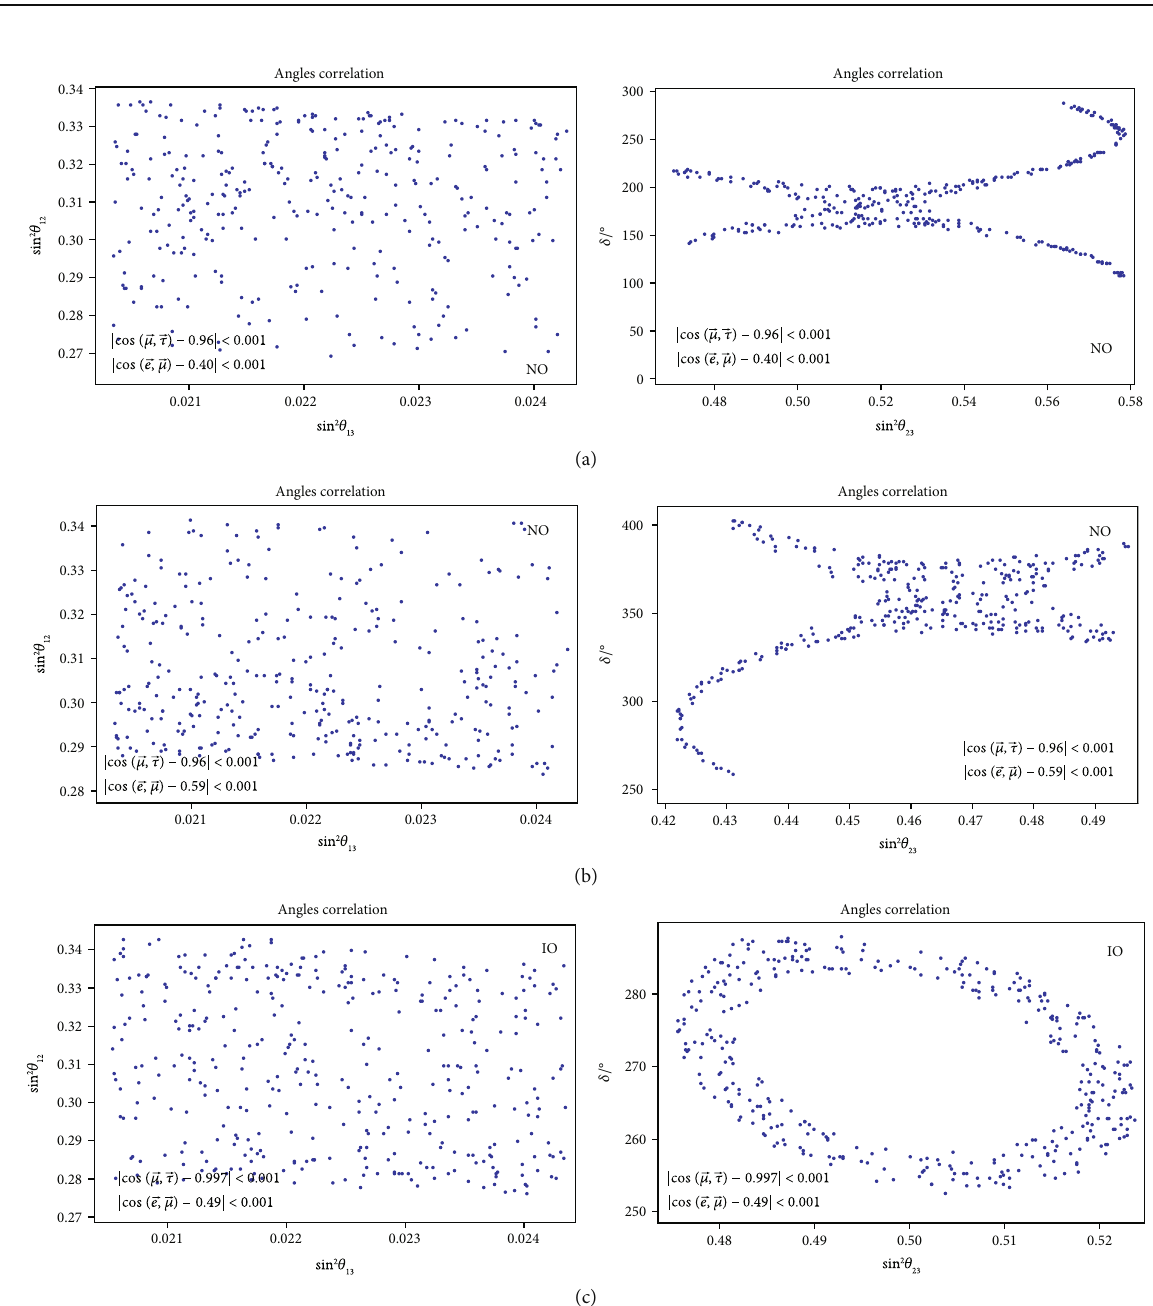
! Þ ! ! ! Þ , cos ð e , τ , μ ) listed in Table 4. 0 0 0 0 ! Þ ! , τ